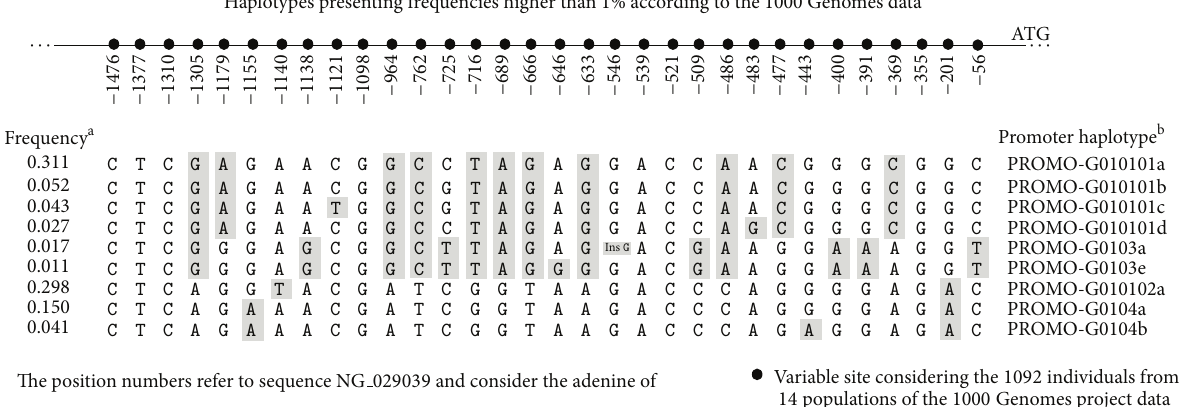
Figure 2: The most frequent haplotypes of the HLA-G 5 󸀠 regulatory region according to the 1000 Genomes data. a Haplotype frequencies considering the 1092 individuals from the 1000 Genomes project [26]. b Haplotypes were named according to [6].